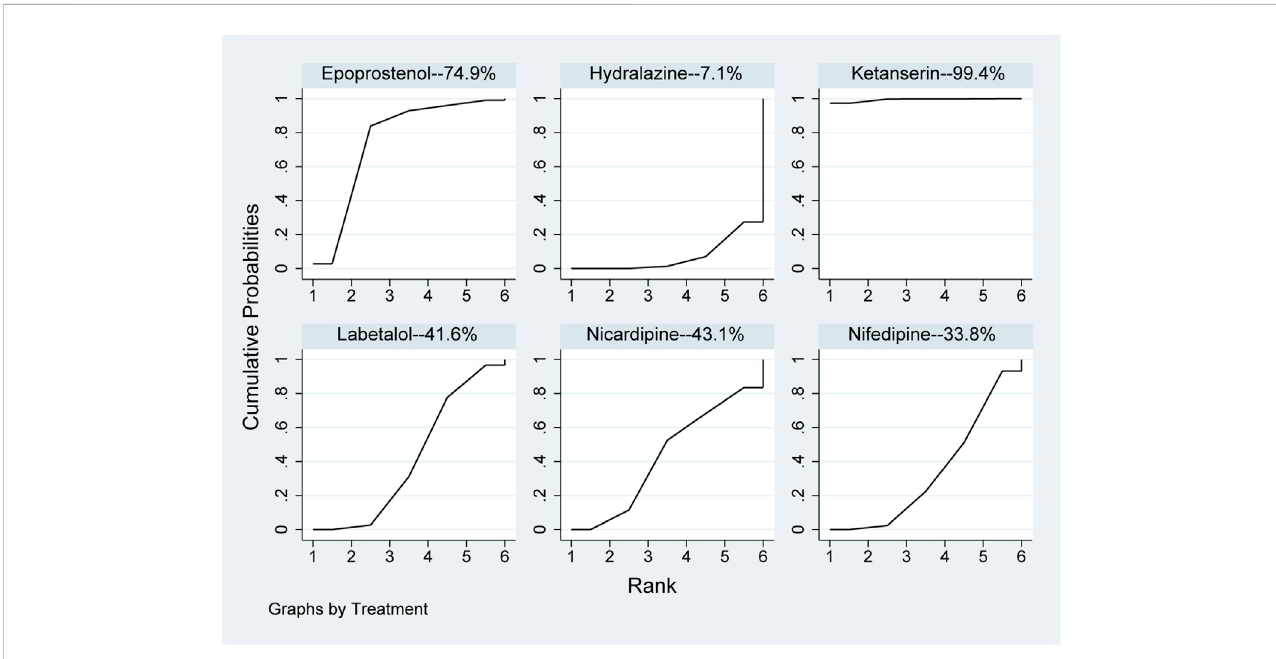
FIGURE 4 Ranking of all pharmaceuticals for the time required to reach the target blood pressure. Note: The larger the area under the curve, the more likely it is to be the best intervention. SUCRA, Surface under the cumulative ranking.